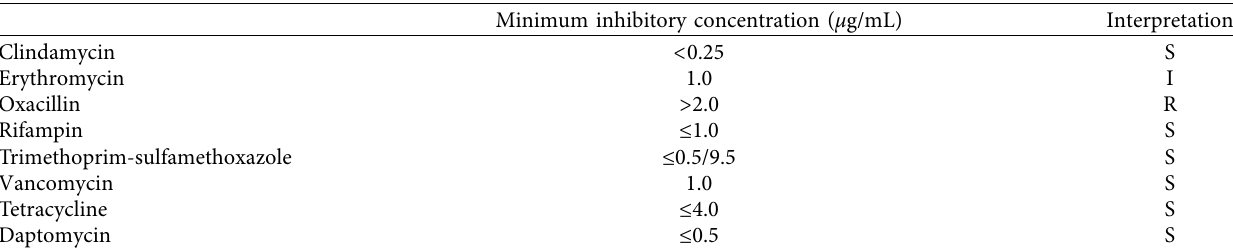
Table 1: Antimicrobial susceptibility testing results based on Microscan testing for Staphylococcus pettenkoferi